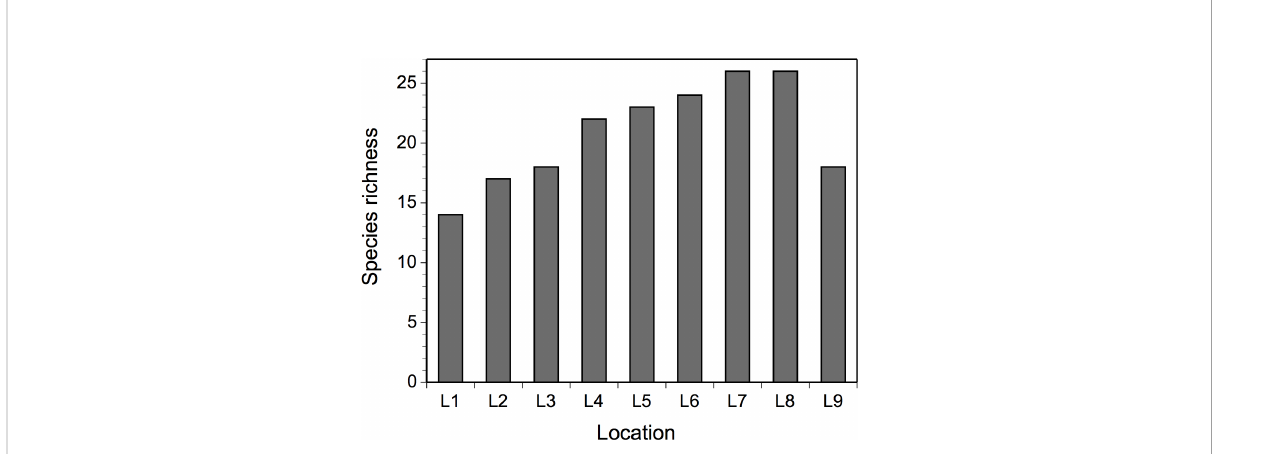
FIGURE 3 Total number of taxa (species richness) identi fi ed at mid-to-high elevations in wave-exposed rocky intertidal habitats at each location during the four studied